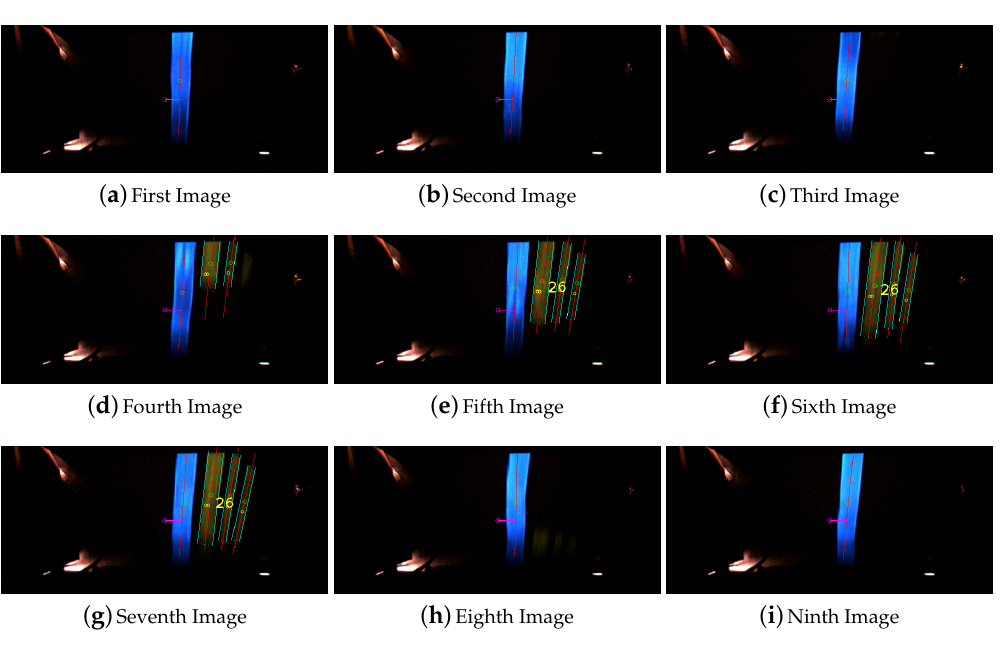
Figure 18. Overpassing and detecting a half-size visual mark at the speed of 15